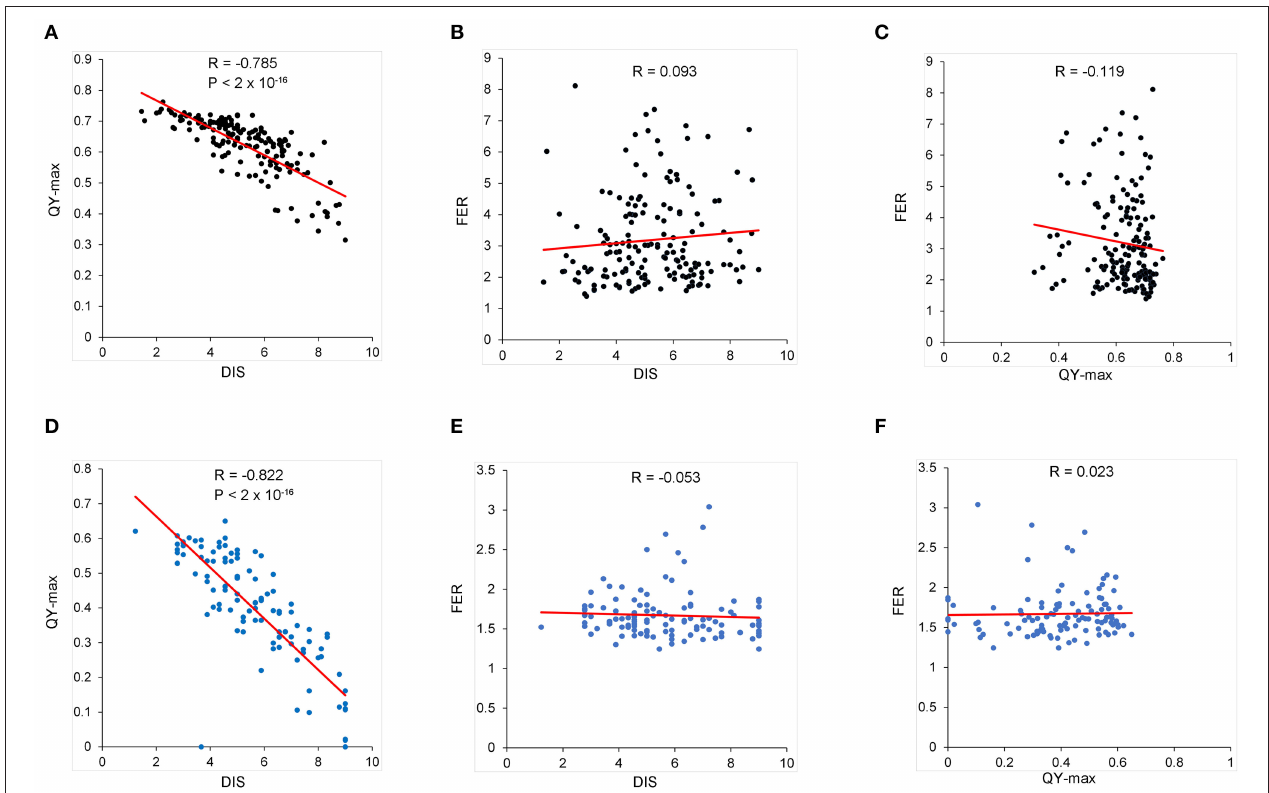
FIGURE 3 | The pairwise correlation among QY, FER, and DIS. (A–C) The data of BD population. (D–F) The data of BP population. The mean of QY and DIS calculated from three replicates, each with nine leaves, was used here. The BLUP value of FER from six replicates in two environments was used